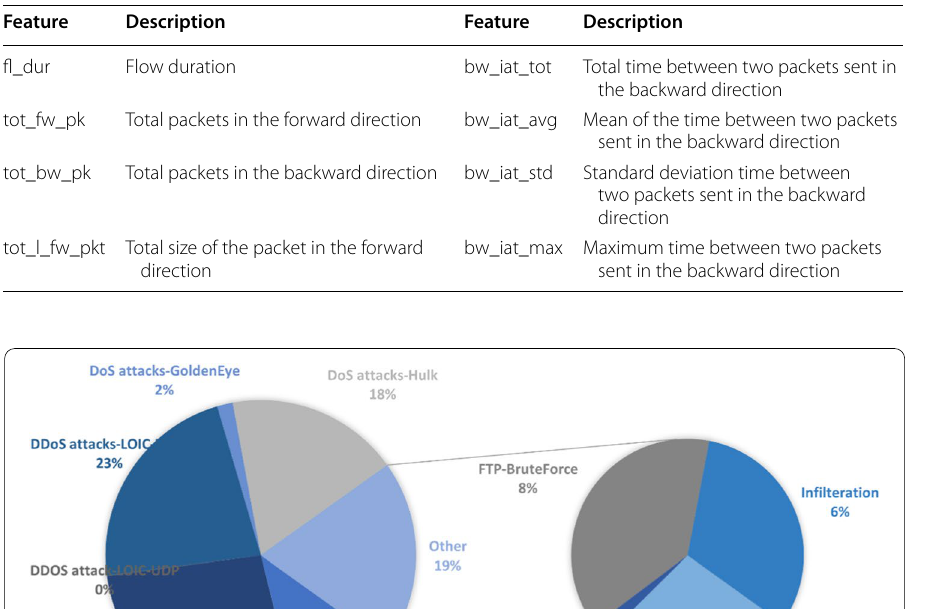
Table 2 Some of the features in the CIC-IDS 2018 Dataset